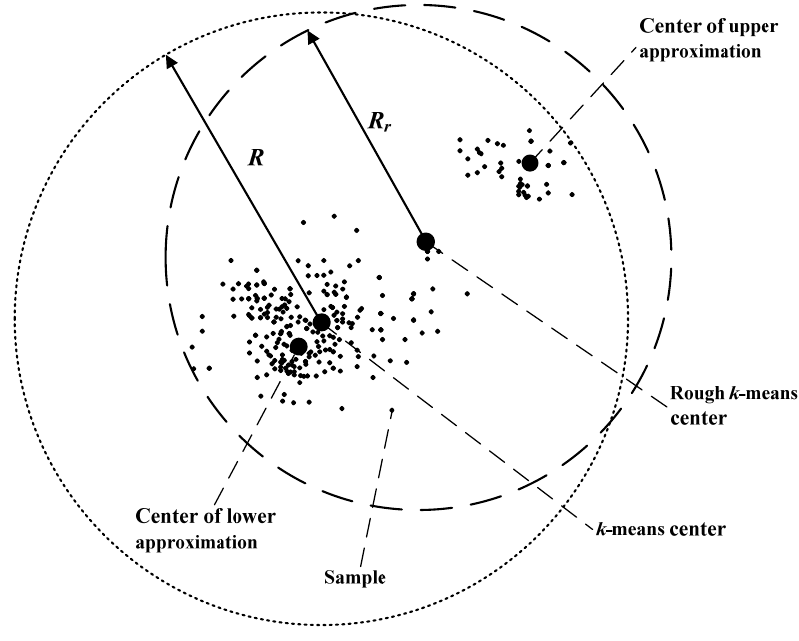
Figure 3. The radius of a cluster in rough k -means is shorter than that in k